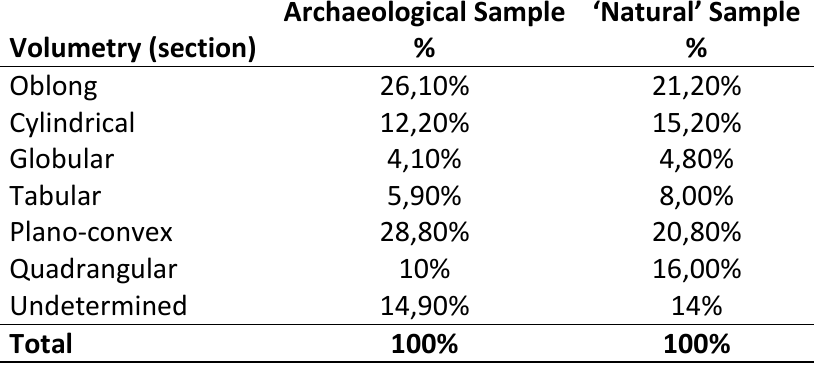
Table 8. Distribution of the observed volumetries in section in the archaeological sample in comparison with the ‘natural’